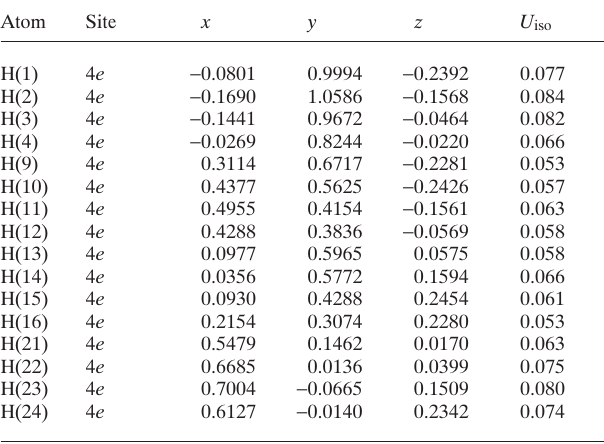
Table 2. Atomic coordinates and displacement parameters (in Å 2 )